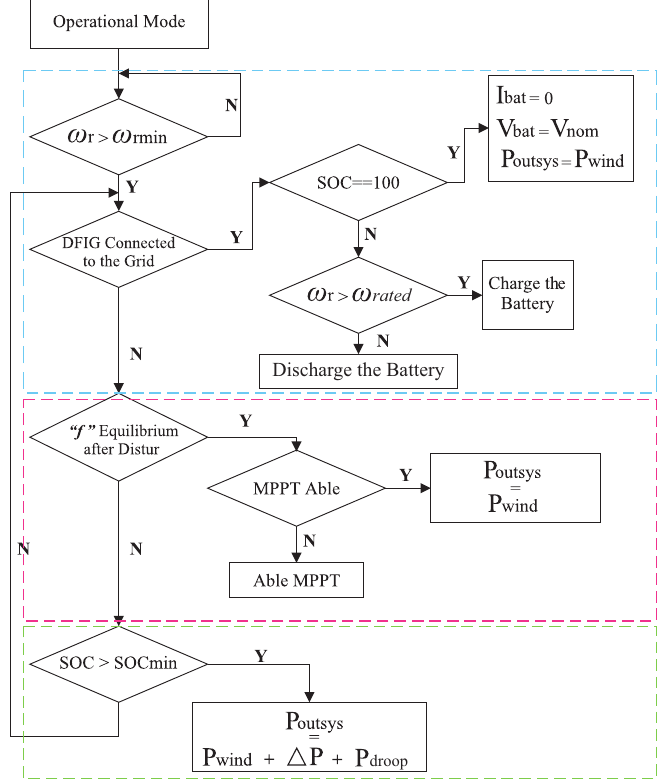
Figure 5. Coordinated control scheme for DFIG and BESS to provide frequency support and battery charging and